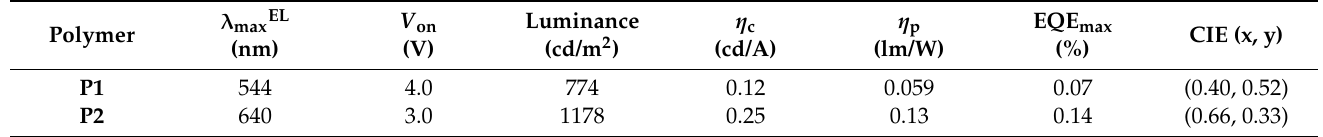
Table 3. Luminescence characteristics of P1 and P2 -based OLED